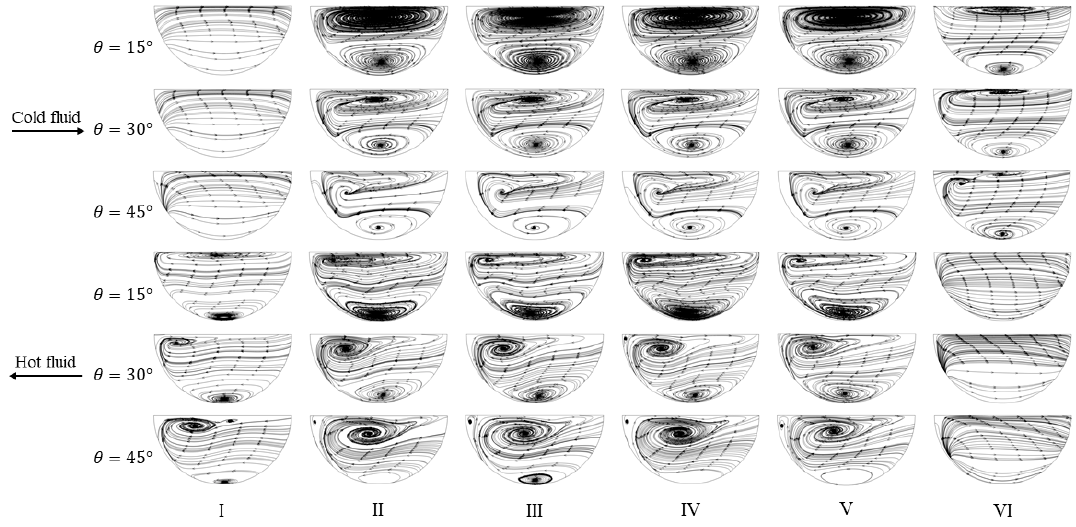
Figure 6. Secondary flow of different cross-sections along the flow direction.